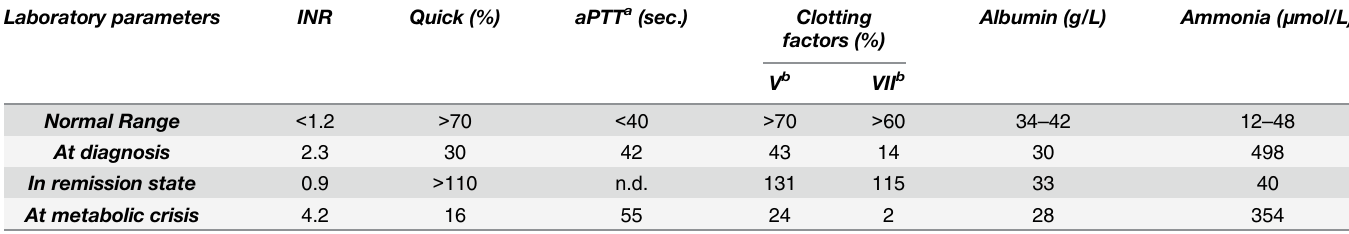
and anticoagulant factors were performed, revealing reduced functional levels of the vitamin K-dependent factors (FII, VII, IX, X, protein C and S) as well as reduced levels of the non-vita- min K-dependent factor V (as depicted in Table 4 for patient 14.1). As anticipated, neither the oral application of 5 mg vitamin K, nor an additional intravenous (i.v.) dose of 5 mg vitamin K led to an increase of the vitamin-K-dependent factors, thus virtually excluding a vitamin K deficiency (Table 4). Hemostatic factors with the shortest plasma half-lives such as factor VII (5 hours) and protein C (7 hours) showed the most pronounced reduction of plasma levels, whereas e.g. factor II with a half-life of 65 hours remained in the subnormal or low normal range. Although not systematically assessed in our patient cohort, in none of the patients we observed a response to vitamin K. Table 3. Association of coagulopathy and acute liver failure with hyperammonemia. INR aPTT a (sec .